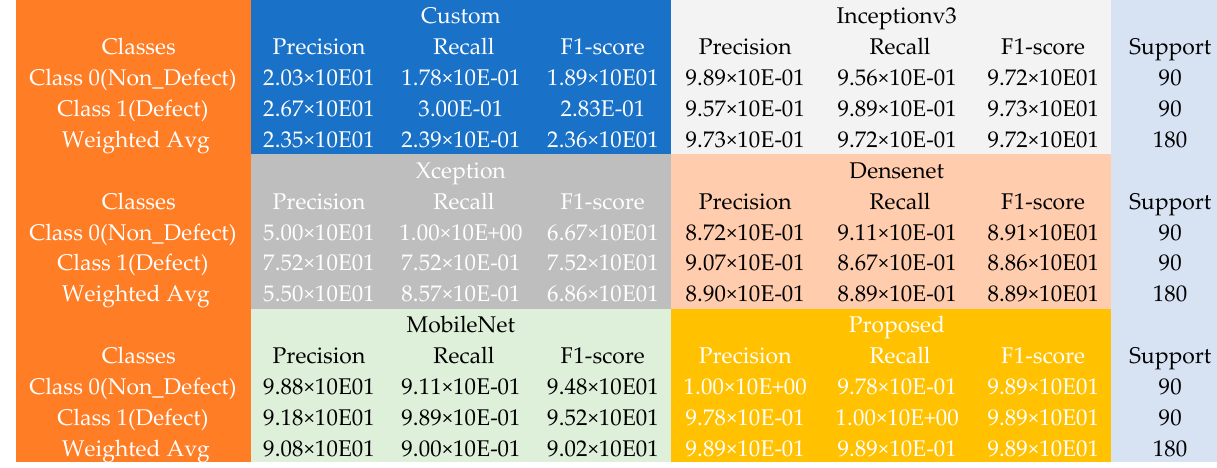
Figure 5. The confusion matrix table using the PCB dataset.